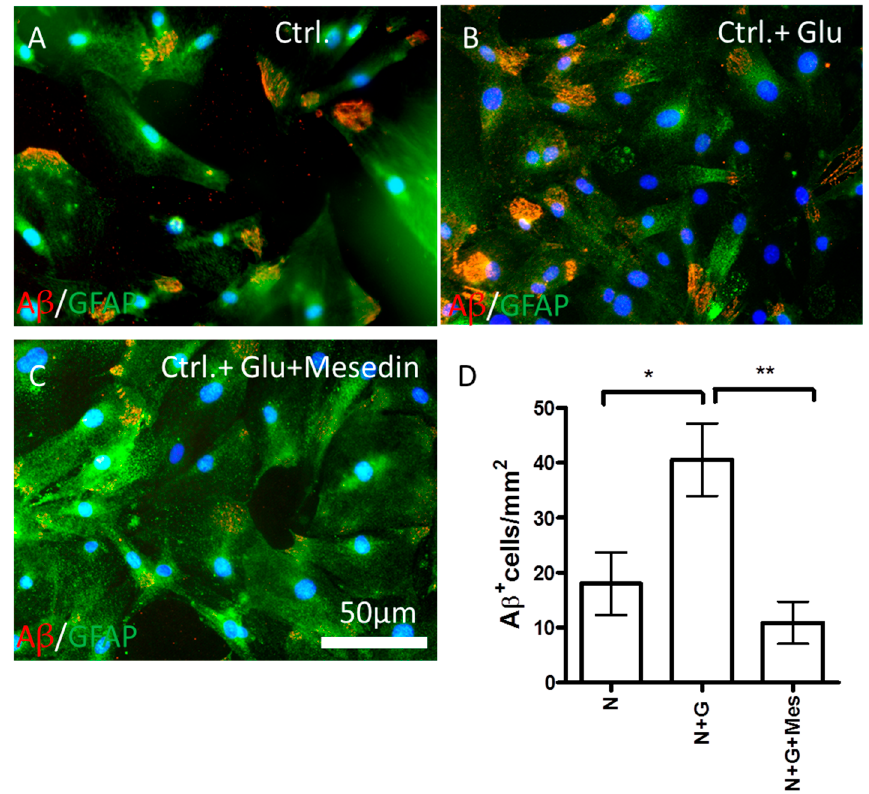
Figure 6. Mesedin reduces intracellular A β in 3×Tg-AD astroglia. Double immunostaining of A β by 6 E10 antibody (red) and GFAP (green) in APC from two-month-old 3×Tg-AD mice upon normoxic control (ctrl.) conditions without and with Glu (( A ) vs. ( B ) respectively) and administration of 10 µM mesedin ( C ). ( D ) The A β + cells were quantified from n = 5 coverslips and normalized to mm². The cell nuclei are counterstained with DAPI (blue). Data are presented as mean ± SEM and analyzed by one-way ANOVA with Bonferroni’s comparison test. * p < 0.05; ** p < 0.01. Scale bar 50 µm.